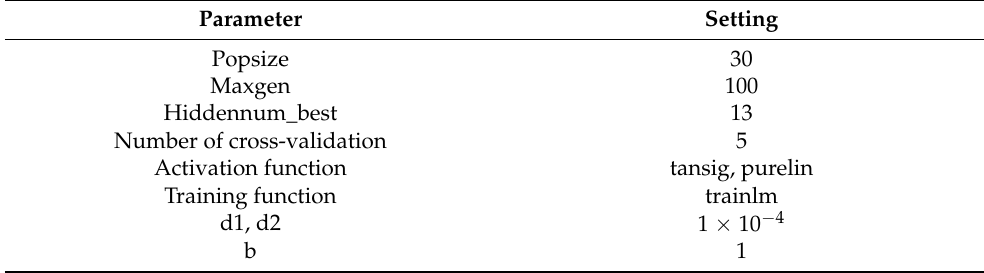
Table 6. Parameter settings for the MWOA-ELMAN model. Parameter